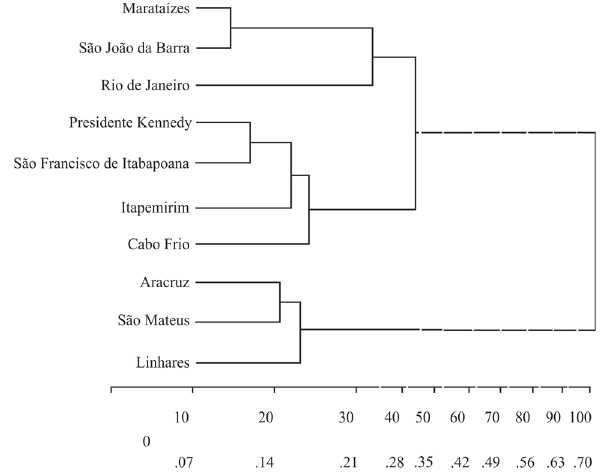
Figure 2 - Dendrogram generated by UPGMA based on the matrix of ge- netic distances between the locations where samples of A. robusta were collected.